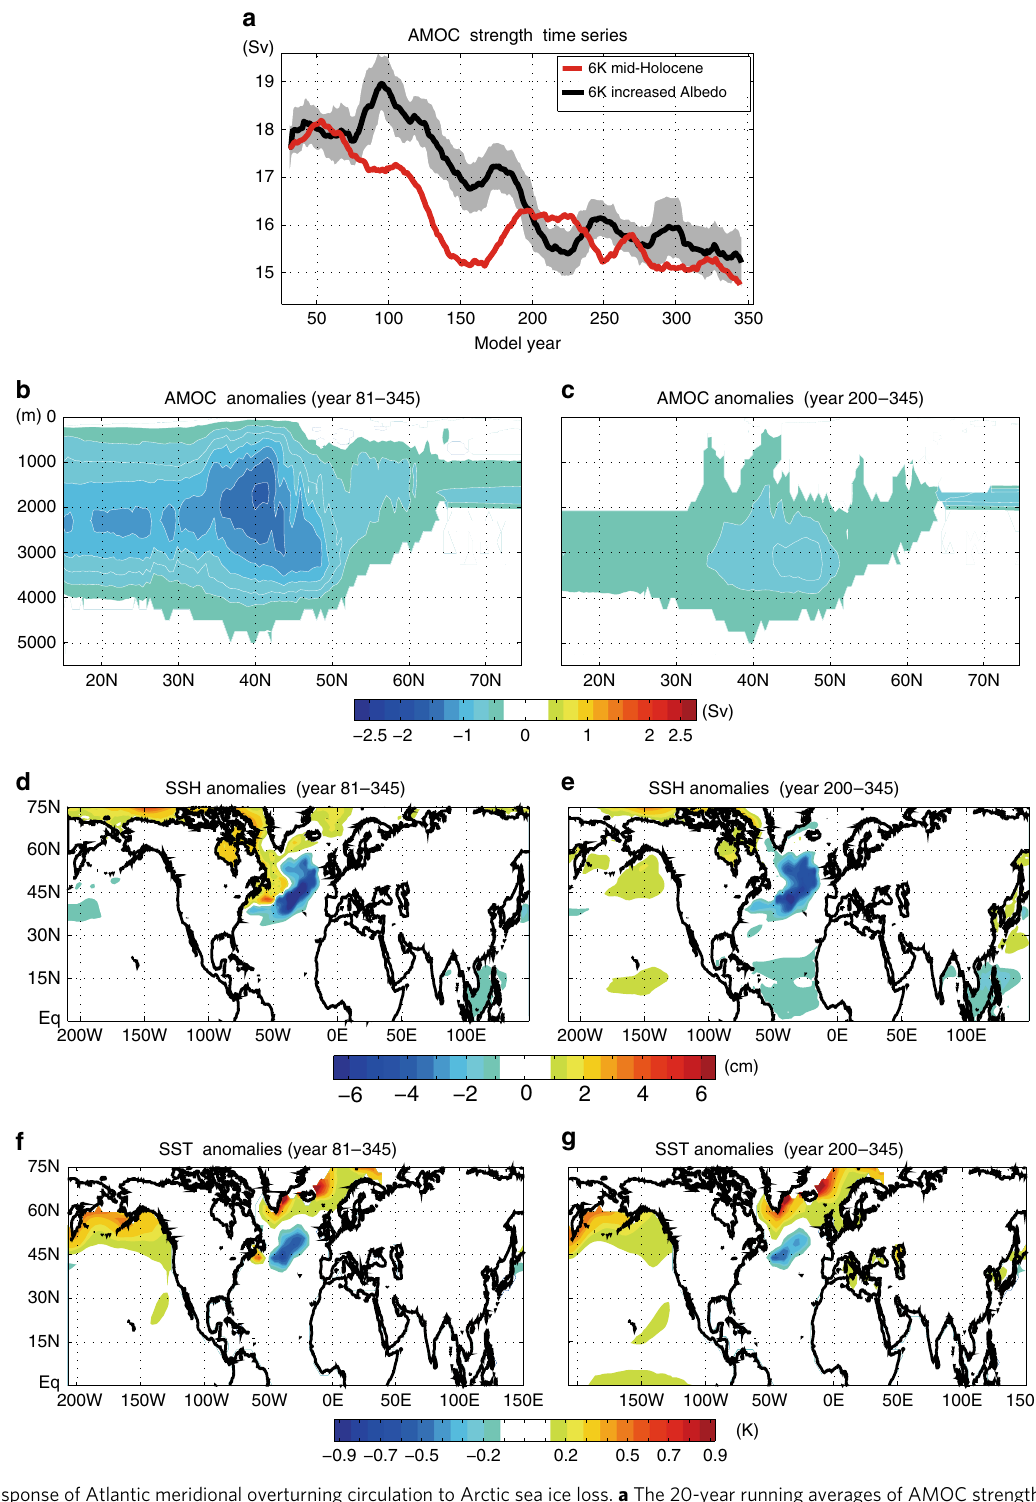
Fig. 5 The response of Atlantic meridional overturning circulation to Arctic sea ice loss. a The 20-year running averages of AMOC strength, de fi ned as the North Atlantic meridional streamfunction (Sv) averaged between depths of 500 and 2500 m, for the mid-Holocene (red) and the mid-Holocene with pre- industrial sea ice (black) simulations. The gray shadings indicate the range of 1 standard deviation from the mean of the mid-Holocene with pre-industrial sea ice (black) simulations. The responses of b , c AMOC (Sv; 1 Sv = 10 6 m 3 s − 1 ), d , e SSH, and f , g SSTs to Arctic sea ice loss averaged over the model years of b , d , f 81 – 345 and c , e , g 200 – 345. Panel f is identical to Fig. 4a. In b and c , the abscissa is latitude and the ordinate is depth (m). In b and c , only statistically signi fi cant values ( p < 0.05) are